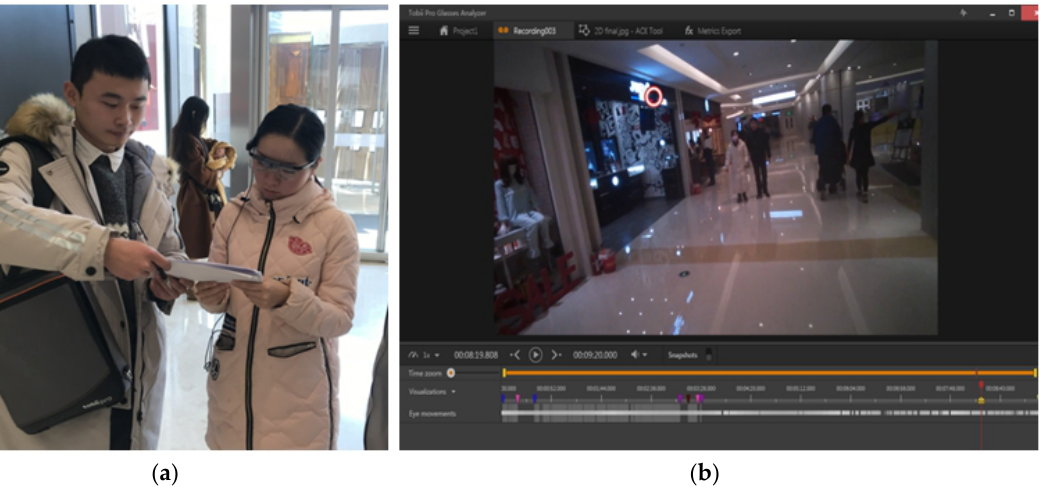
Figure 1. Equipment and analyzing application: ( a ) Participant wearing Tobii Glasses 2 in pre-test phase and ( b ) Tobii Pro Glasses Analyzer.